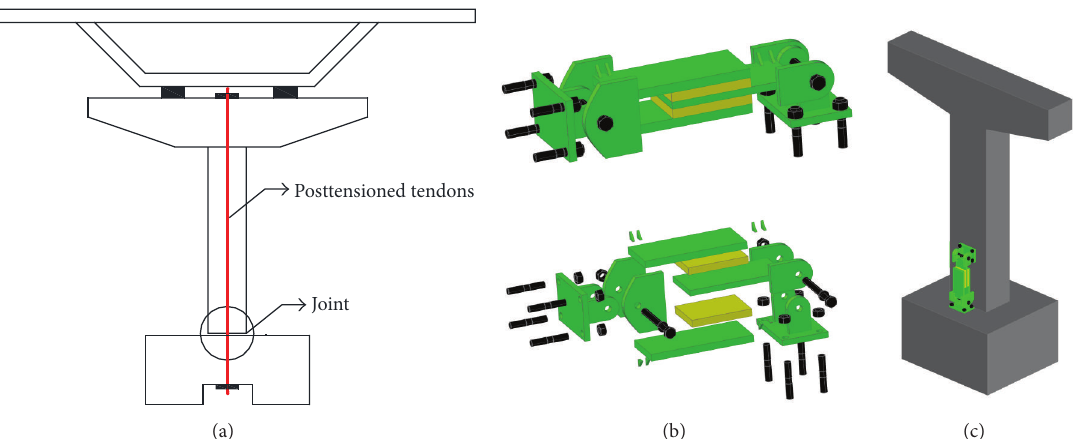
Figure 1: Schematic diagram of the self-centering bridge piers: (a) common self-centering bridge with posttensioned tendons; (b) configuration of the viscoelastic damper; (c) installation scheme of the viscoelastic